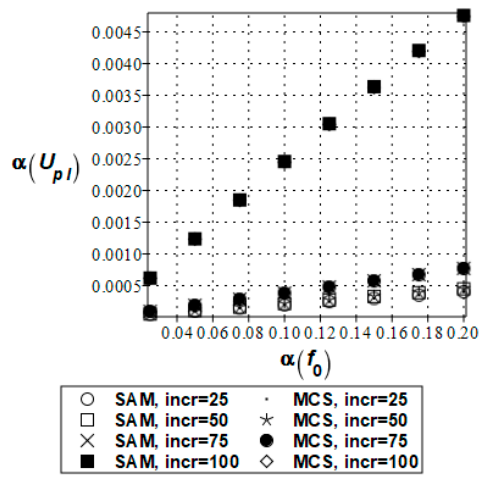
Figure 7. Coefficients of variation of elastic energy fluctuations.